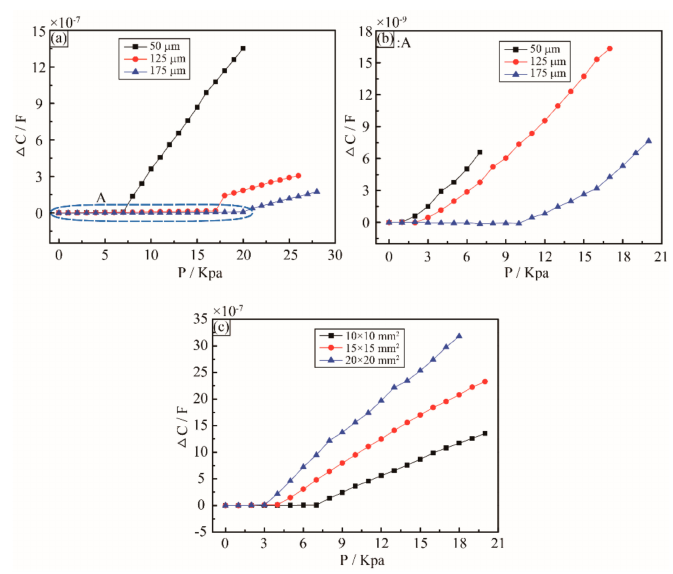
Figure 4. Influence of geometrical parameters on the sensor sensitivity. ( a ) Different thickness of the sensing membrane, 50 µ m, 125 µ m, and 175 µ m. ( b ) The enlargement of the low pressure region A in Figure 4a. ( c ) Different areas of the sensing chamber, 10 mm × 10 mm, 15 mm × 15 mm, and 20 mm × 20 mm.